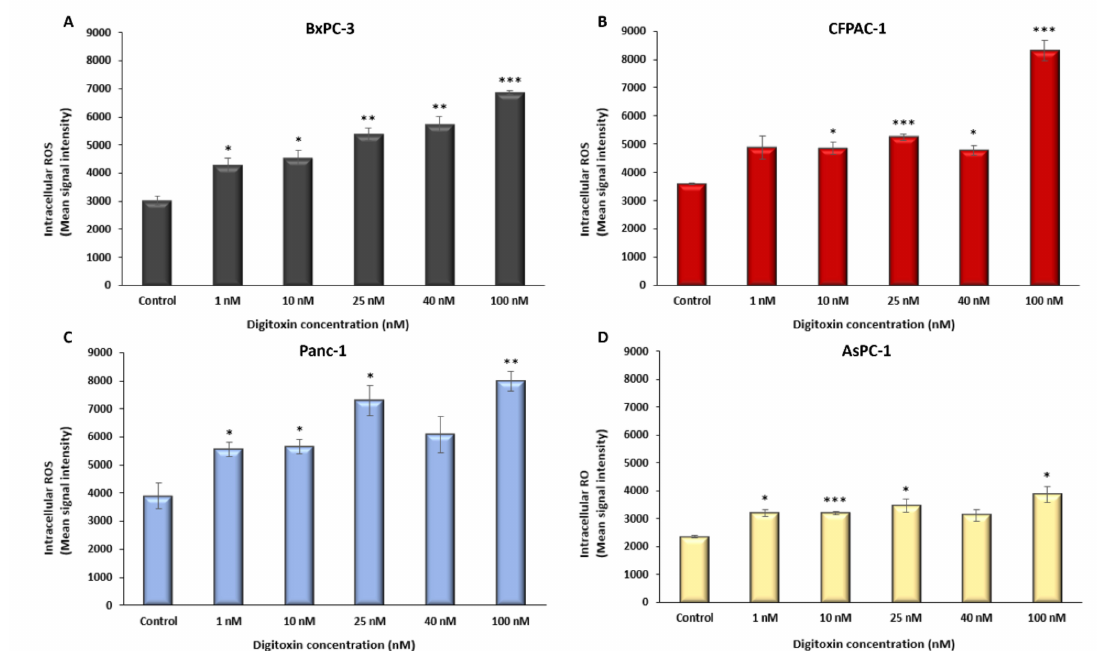
Figure 3. Intracellular ROS in PDAC cells after 48 h of digitoxin treatment and for the controls without digitoxin. ( A ) BxPC-3, ( B ) CFPAC-1, ( C ) Panc-1, and ( D ) AsPC-1 intracellular ROS as the mean signaling intensity. Digitoxin concentrations in nM on the x axis. ROS values normalized to MTS and the control for each cell line. Error bars = SEM, Student’s t -test * p ≤ 0.05, ** p ≤ 0.01 and *** p ≤